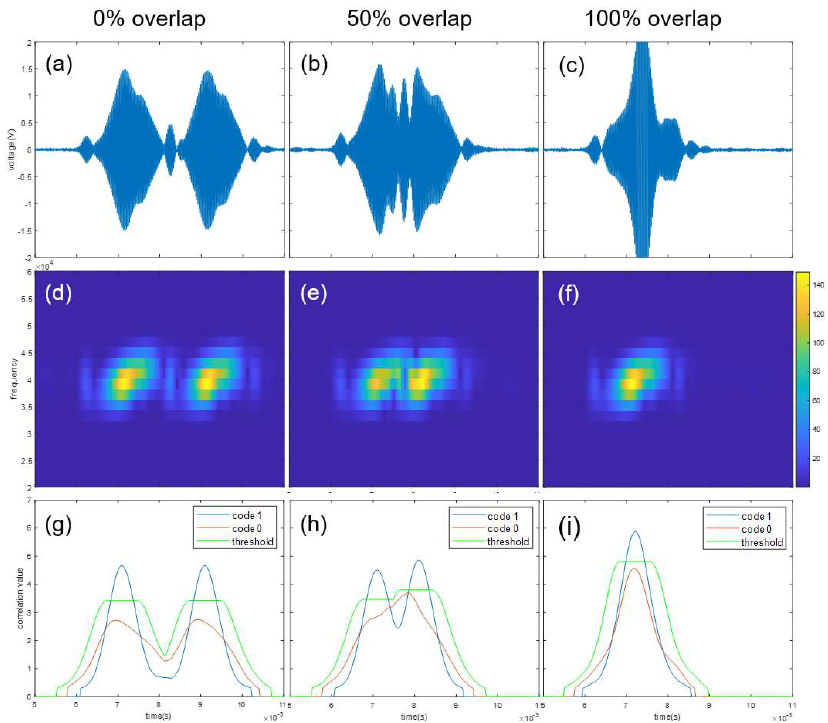
Figure 7. Demodulation results when two transmitters transmit the same bit codes, “1” and “1”. Shown are ( a , d , g )—0% overlap; ( b , e , h )—50% overlap; ( c , f , i )—100% overlap; ( a – c )—received signal; ( d – f )—spectrogram; and ( g – i )—code mask correlation result and threshold value.